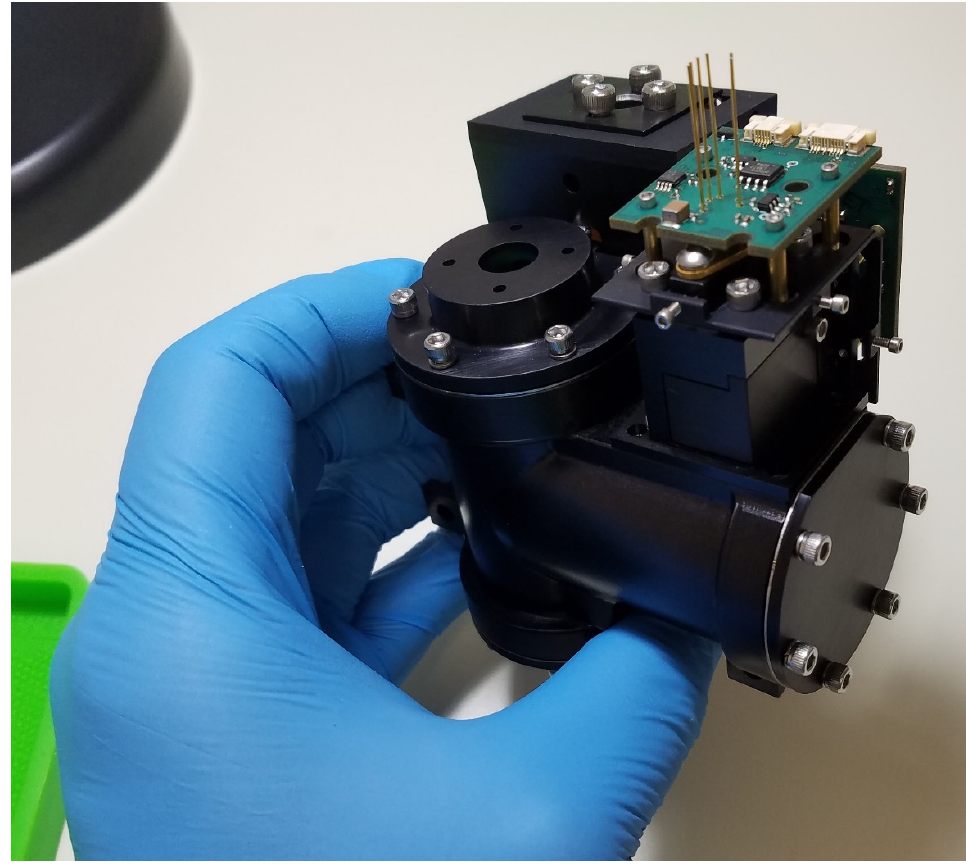
Figure 8. In this photo, the AFN is at 80% completed assembly. Here, is shown the entire optical assembly with detector electronics.